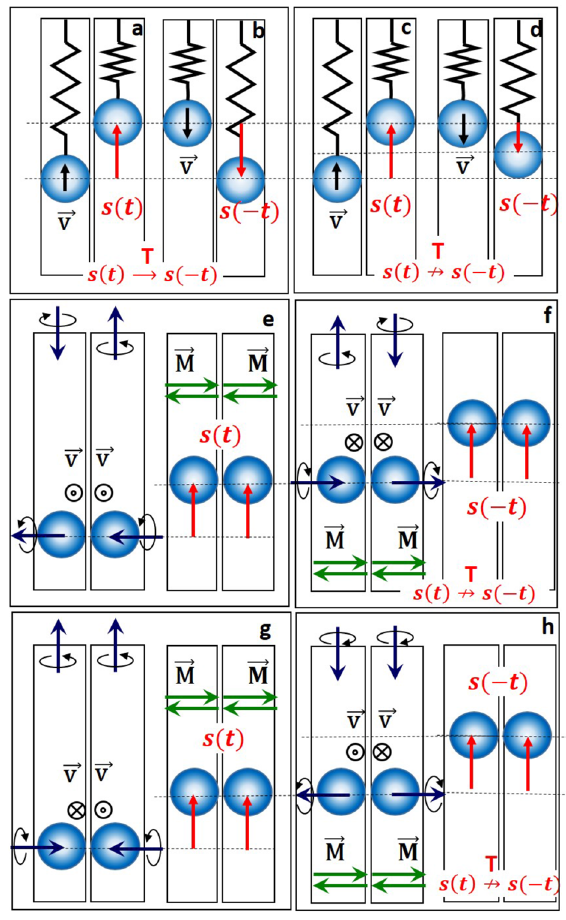
Figure 4. Time-reversal symmetry breaking. ( a,b ) Side-view of the forward-in-time ( s ( t ) ) and backward- in-time ( s ( − t ) ) trajectories of an ideal harmonic oscillator. Time-reversal symmetry is preserved. (c,d) Real harmonic oscillator with dissipation. Time-reversal symmetry is broken because | s ( t ) | �= | s ( − t ) | , reversed order of events is preserved. ( e–h ) Side-view of the embodiment revealing a lifting force for different combinations of tubes’ rotations corresponding to the forward-in-time ( e,g ) and the backward-in-time motion ( f,h ). Black arrows indicate the angular momenta of the tubes and those of the spheres. Red arrows indicate trajectories. Green arrows show the allowed orientation of